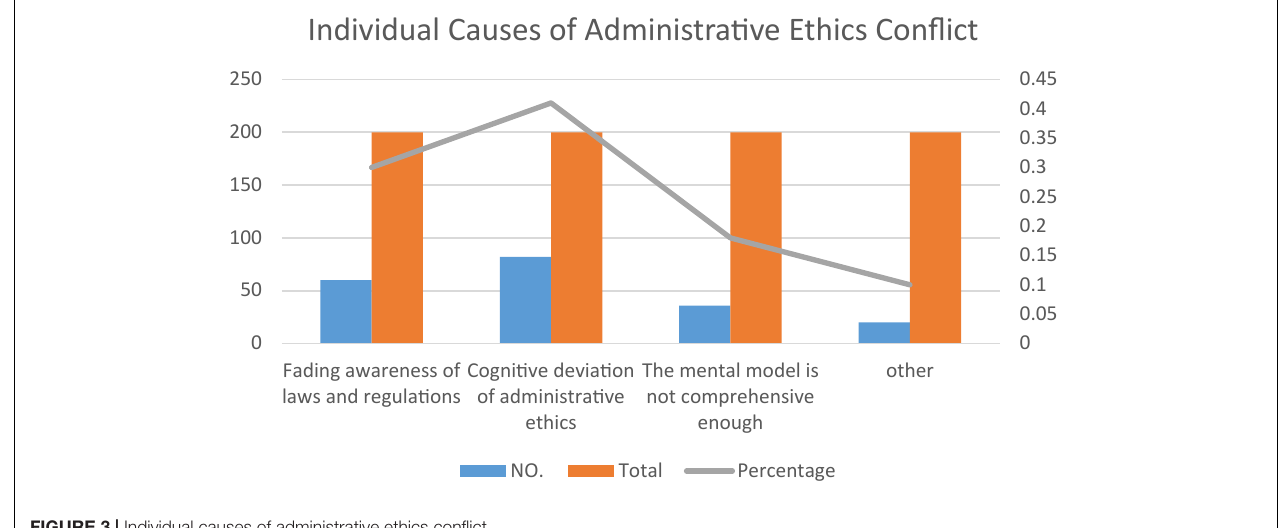
FIGURE 3 | Individual causes of administrative ethics